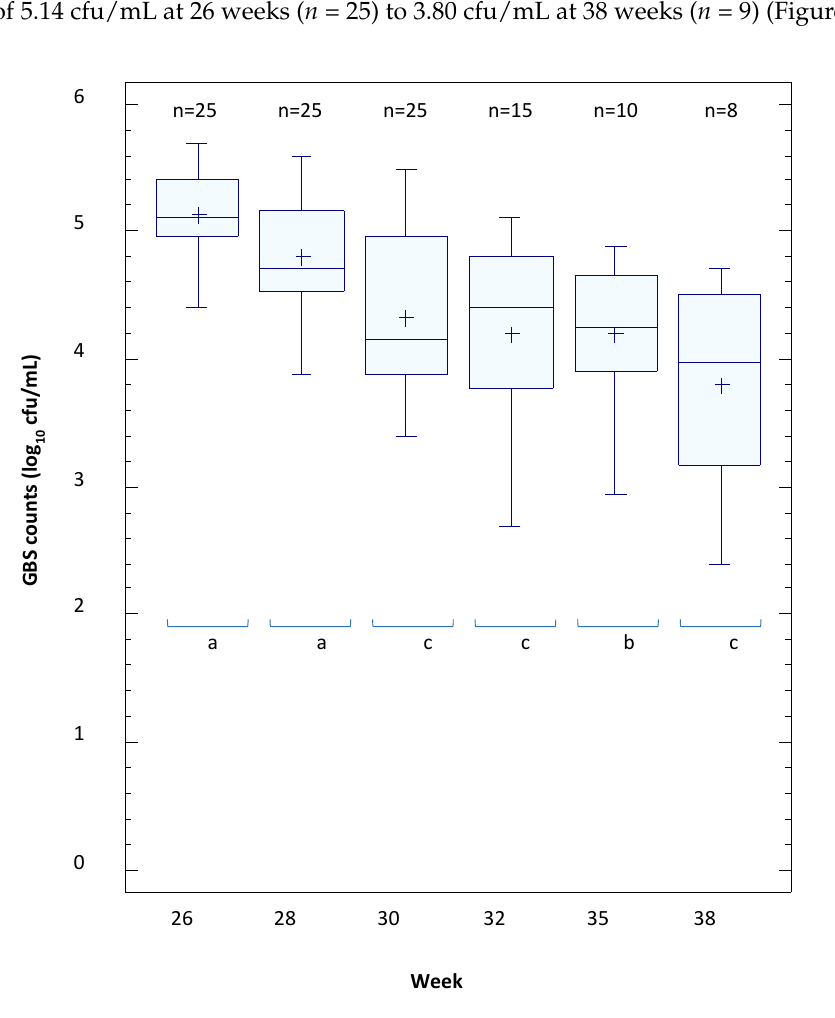
Figure 2. The mean concentrations (CFU/mL) of S. agalactiae (GBS) in vaginal swabs sampled regularly up to the delivery from Group B Streptococci (GBS)-positive women taking 9 log 10 cfu of L. salivarius CECT 9145 daily. Statistically significant differences between samples taking at different sampling times are indicated by letters (Bonferroni post-hoc test).